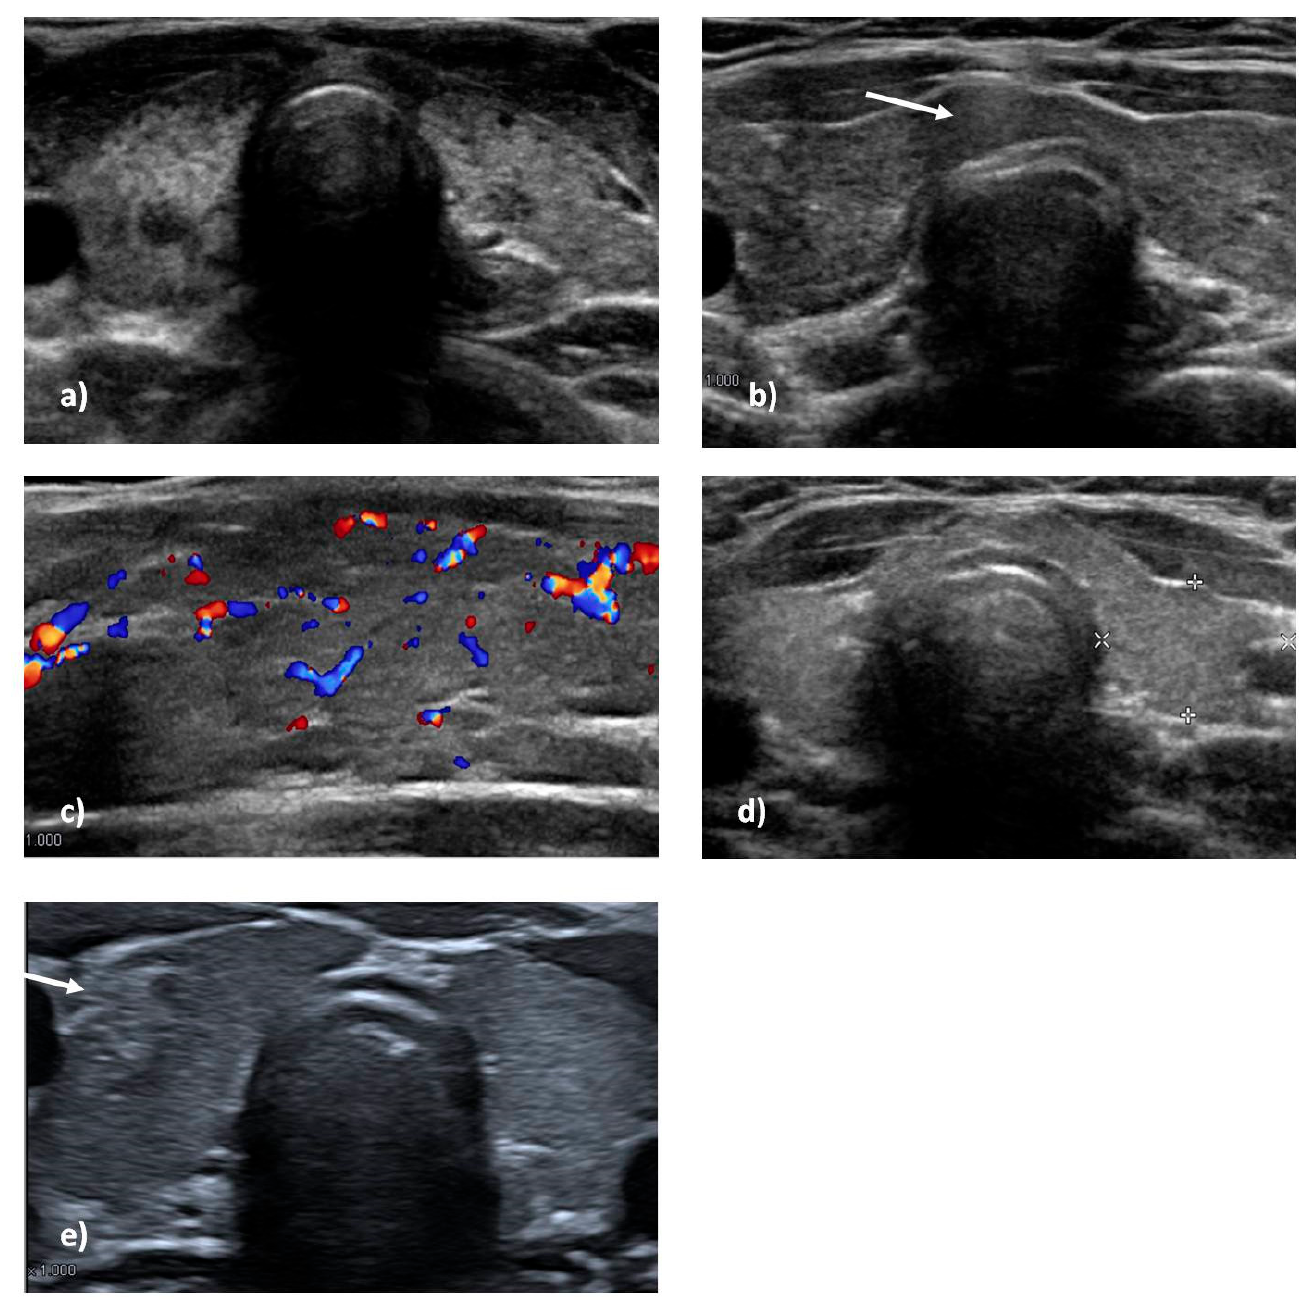
Figure 1. Cervical ultrasonography in some patients with 22q11.2 Deletion Syndrome: thyroid gland hypoplasia as well as inhomogeneity, diffuse hypoechoic areas, and pseudonodular pattern ( a ); diffuse inhomogeneity, hypoechogenity, and perithyroidal lymph node (white arrow) ( b ). Increased overflow of thyroid lobe on color doppler ultrasonography ( c ). Left lobe hypoplasia ( d ); right thyroid lobe neoplasia in a patient with Graves’ disease (white arrow) ( e ). Table 3. Thyroid Morphological Ultrasound Features in 22q11DS patients.